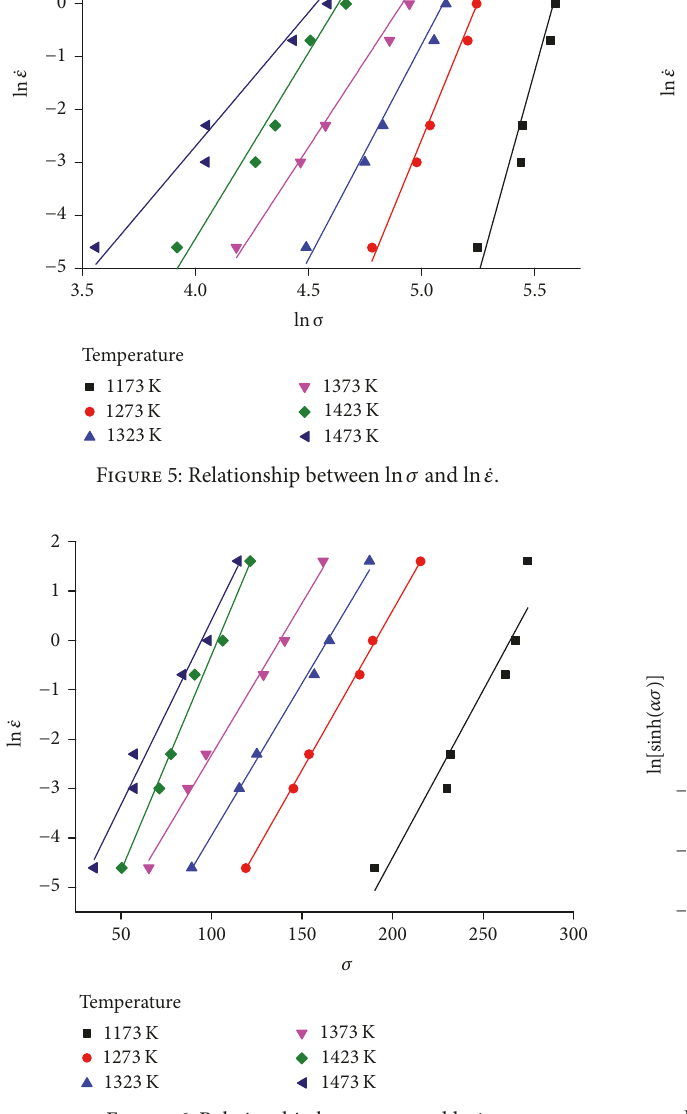
Figure 8: Relationship between 1000/𝑇 and ln [ sinh (𝛼𝜎)]